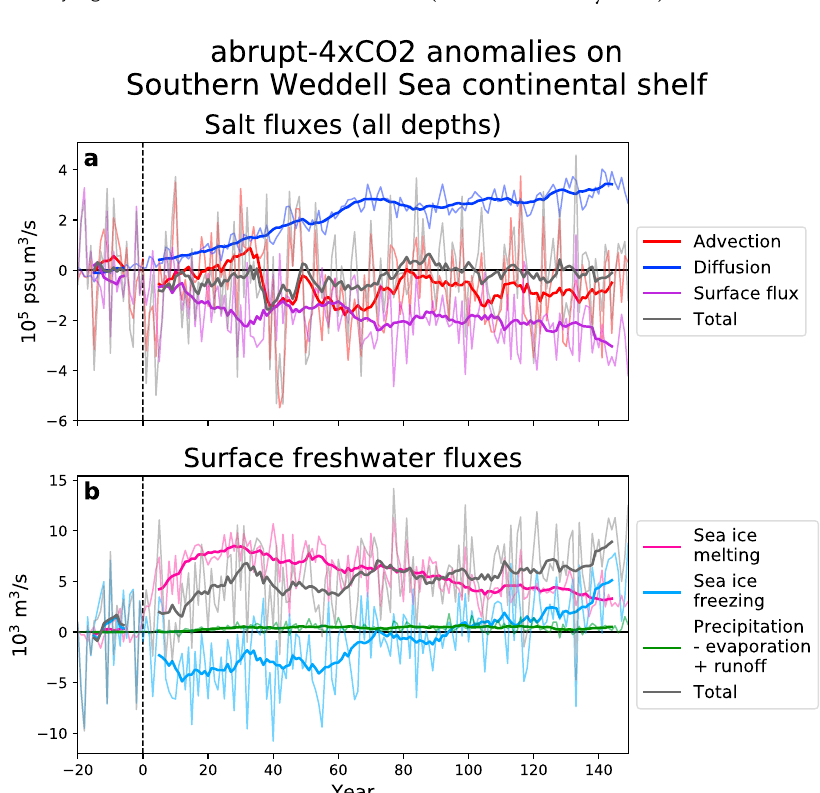
Fig. 3 Salt budget analysis for the southern Weddell Sea continental shelf. The timeseries show abrupt-4xCO2 anomalies from the last 20 years of the pre-industrial spinup. The spinup period is shown in the time before year 0, to indicate the variability. Thinner lines show annual averages, while thicker lines show the 11-year running means (calculated separately for the periods before and after year 0 so as not to confound the transition). The region is de fi ned in Supplementary Fig. 5. a Integrated salt fl uxes in 10 5 psu m 3 /s. The advection timeseries includes the surface correction term from MITgcm ’ s linear free surface scheme. b Integrated surface freshwater fl uxes in 10 3 m 3 /s. Note the opposite sign to ( a ). Sea ice freezing refers to the freshwater fl ux from sea ice freezing, which has the opposite sign to the freezing rate